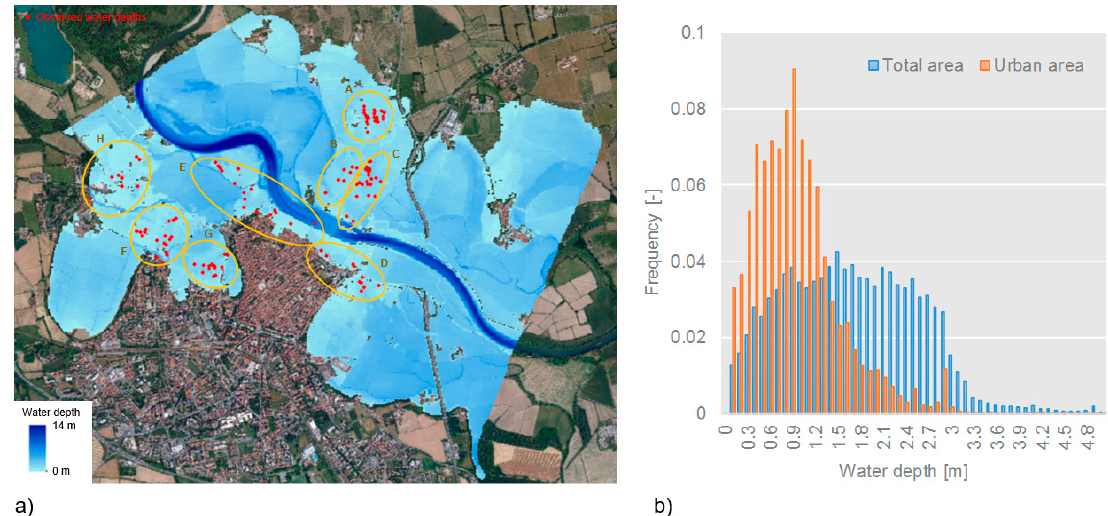
Figure 4. Results of the 2D model for the 2002 Adda flood: ( a ) Flood depth map, with indication of clusters considered in the calibration of the model; ( b ) Distributions of water depths in the total inundated area and urban areas only.